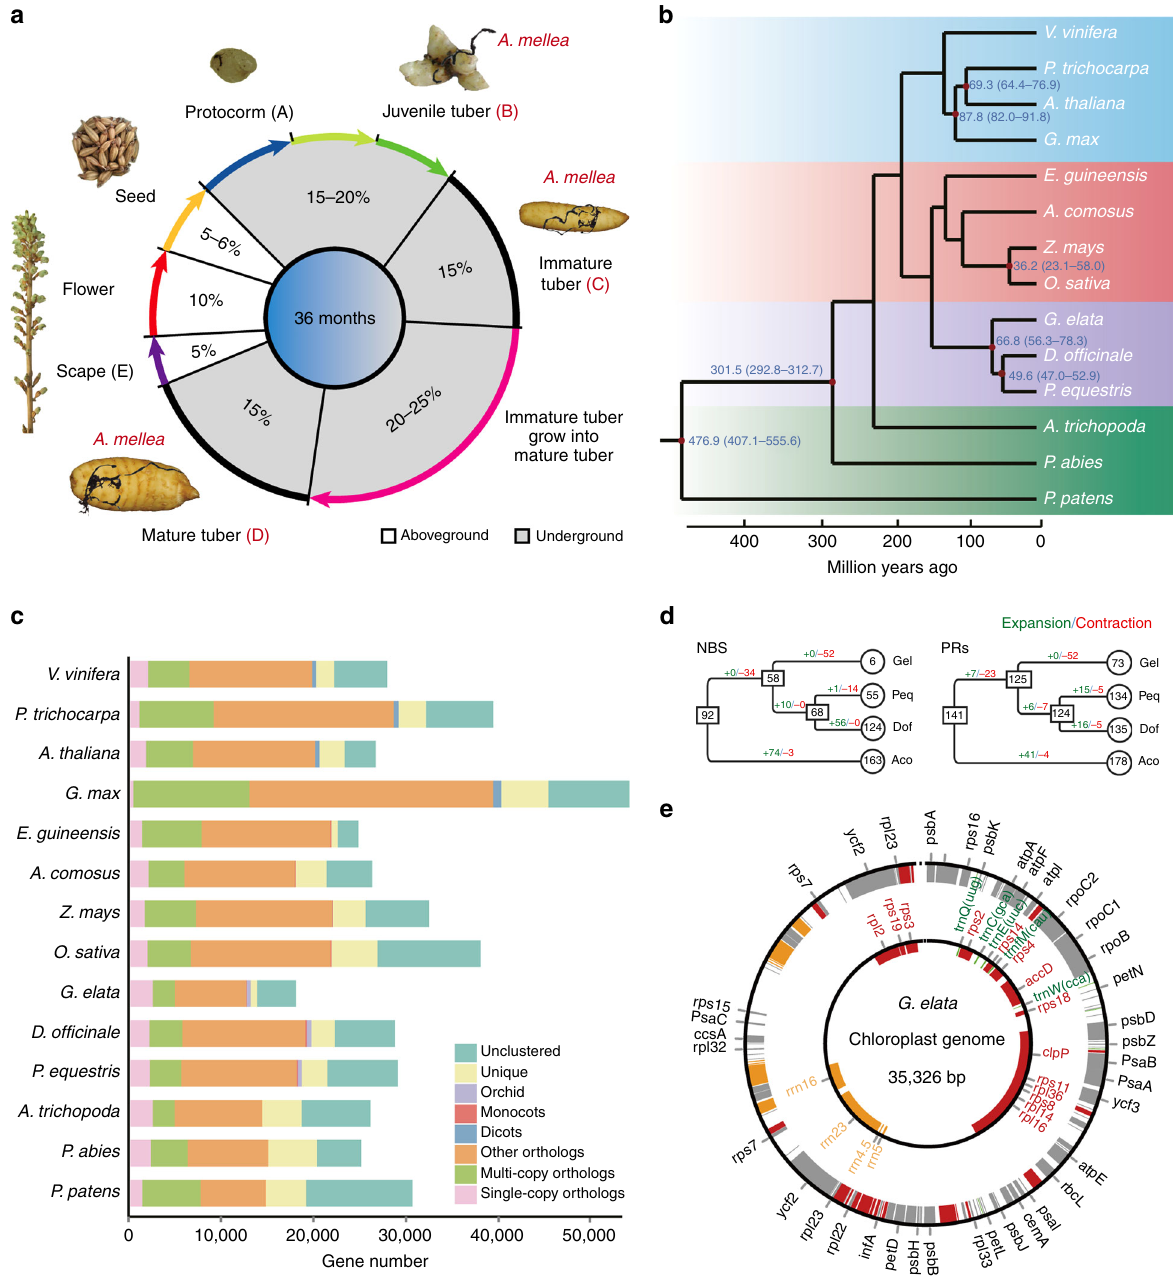
Fig. 1 Gastrodia elata life cycle and gene-family contraction. a The main developmental stages of G . elata . Seeds develop into a protocorm stage without requiring A . mellea (A). The protocorm then differentiates into a corm stage after commencing its association with A . mellea ; note that lateral buds develop into juvenile tubers (B). Young and immature tubers (C). Mature tuber with an emergent young scape (D). Scape (stem and in fl orescence) of mature plants (E). b Phylogenetic tree of 14 plant species including G . elata . The red dot represents a calibration point determined from the timetree website. c Bar graph of the number of protein-coding genes in each of the species. Single-copy orthologs include common orthologs with one copy in speci fi c species. Multi-copy orthologs include common orthologs with multiple copy numbers in speci fi c species. Other orthologs include genes from families shared in 2 – 13 species. ‘ Eudicot ’ clusters with eudicots. ‘ Monocots ’ clusters with monocotyledonous plants. ‘ Orichd ’ clusters with G . elata , P . equestris , and D . of fi cinale . ‘ Unclustered ’ include genes that cannot be clustered into gene families. d Analysis of gene numbers in the genomes of four species for the nucleotide-binding site gene family (NBS), the pathogenesis-related protein (PR) family (Gel G . elata, Peq P . equestris , Dof D . of fi cinale , Aco A . comosus ). Numbers in circles represent the number of family members in each genome, and numbers with plus or minus signs indicate, respectively, the number of duplicated or deleted genes. e The plastid genomes of P . equestris (outer circle) and G . elata (inner circle). Red, protein; orange, rRNA; green, tRNA; gray, genes lost from the plastid genome of G .